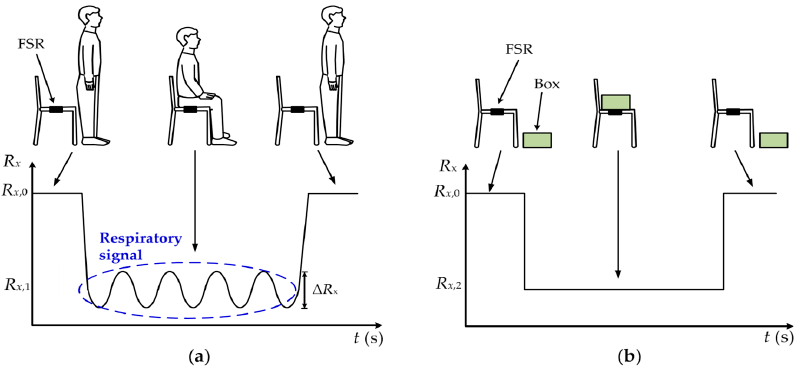
Figure 1. FSR variations when over the chair we have: ( a ) a subject; ( b ) an object.